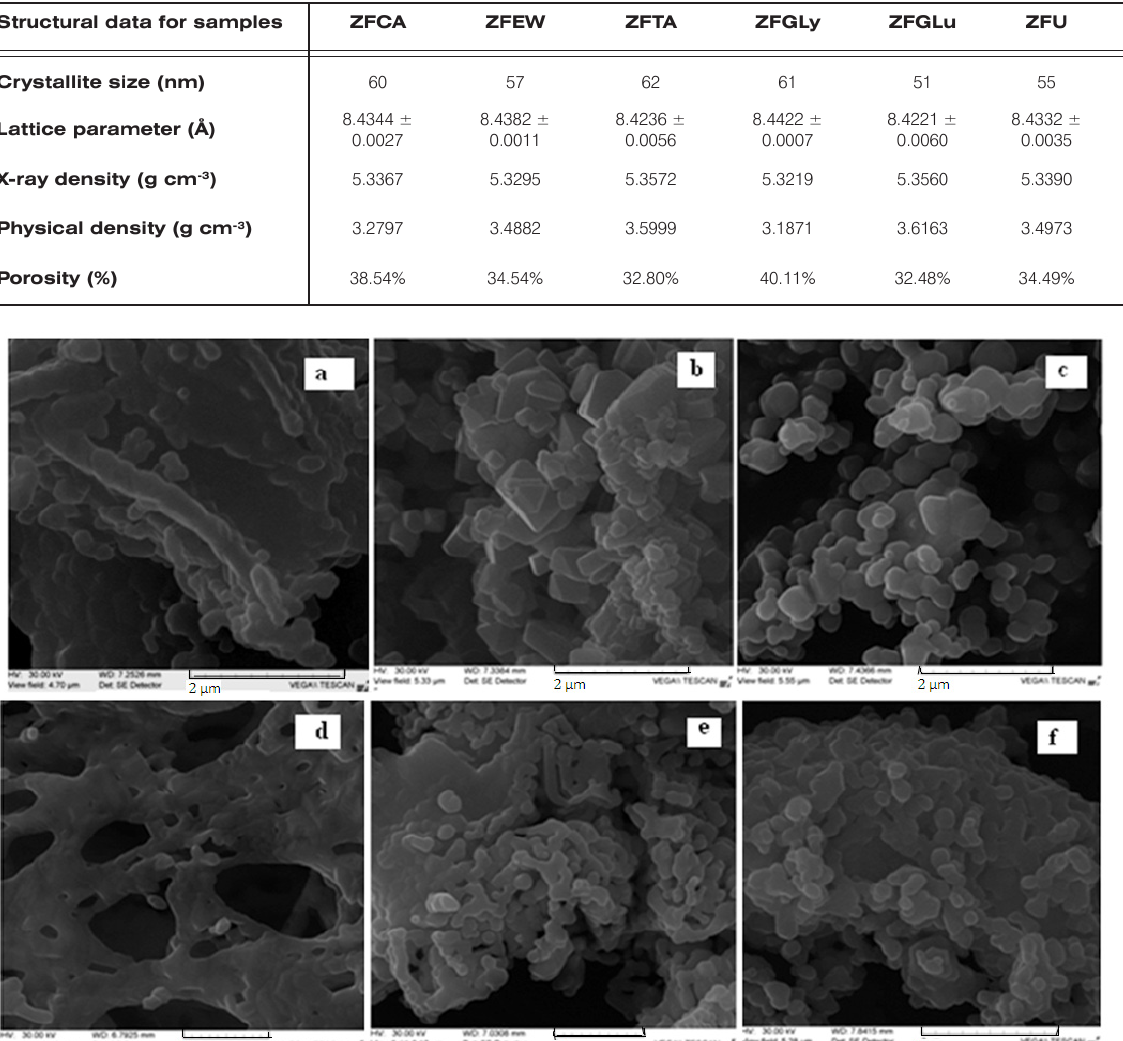
Table 4. XRD data, physical density and porosity for ZF samples heat treated at 1173 K. Structural data for samples